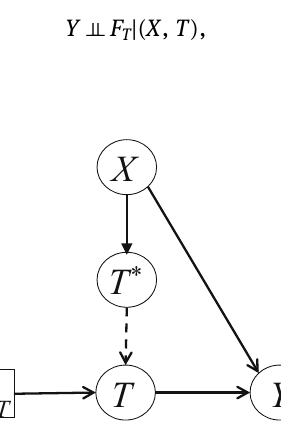
Figure 9: Full DAG with su ffi cient covariate X and regime indicator.